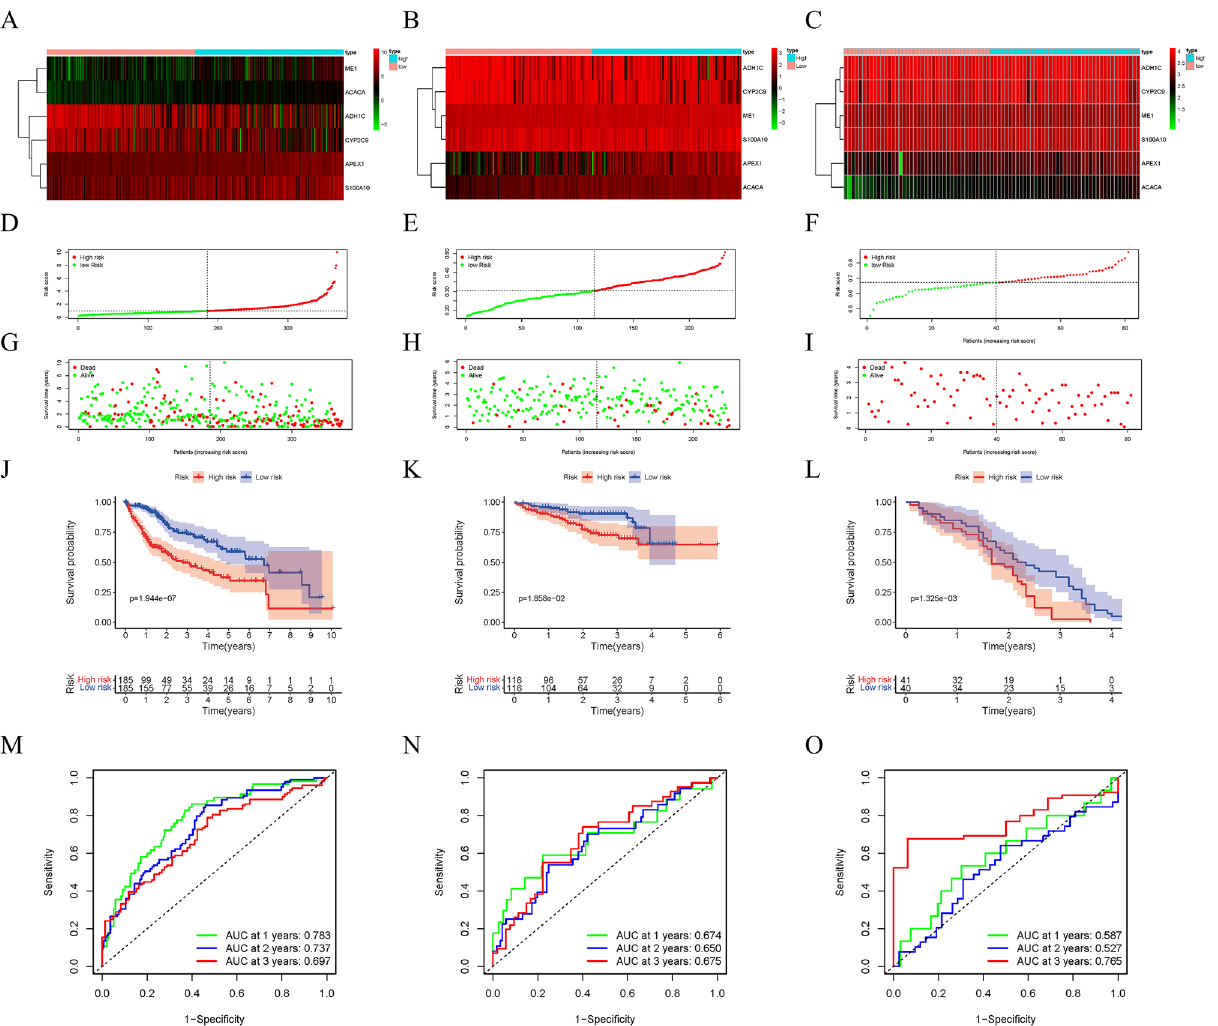
Figure 4. Verification of the prognostic models. Heat map (using “pheatmap” R package, https:// cran.r- proje ct. org/ bin/ windo ws/ base/ old/4. 1.3/) of the expression of 6 lipid metabolism related genes in HCC samples in TCGA ( A ), ICGC ( B ) and GSE54236 ( C ). ( D – F ) Distribution of risk scores for HCC samples in above three datasets. ( G – I ) The relationship between survival time and status of HCC samples and risk score in above three datasets. ( J – L ) Kaplan–Meier survival curve of samples in high- and low-risk groups in above three datasets. ( M – O ) ROC curve of risk score in samples with HCC in above three